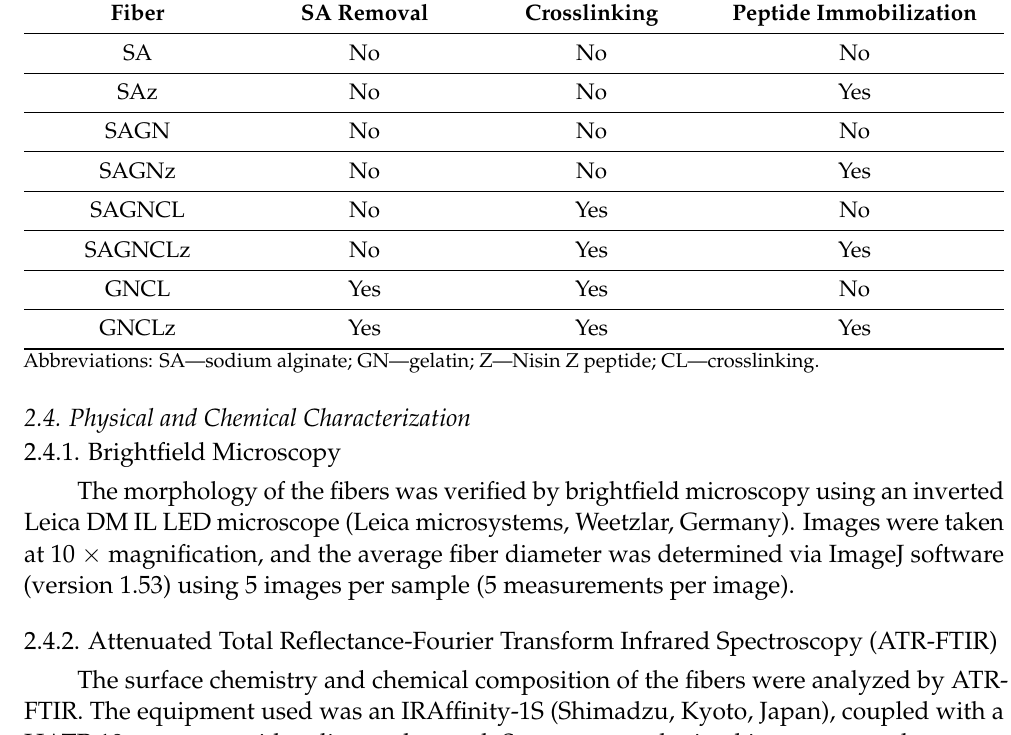
Table 1. Produced fibers and respective treatments employed. Fiber SA Removal